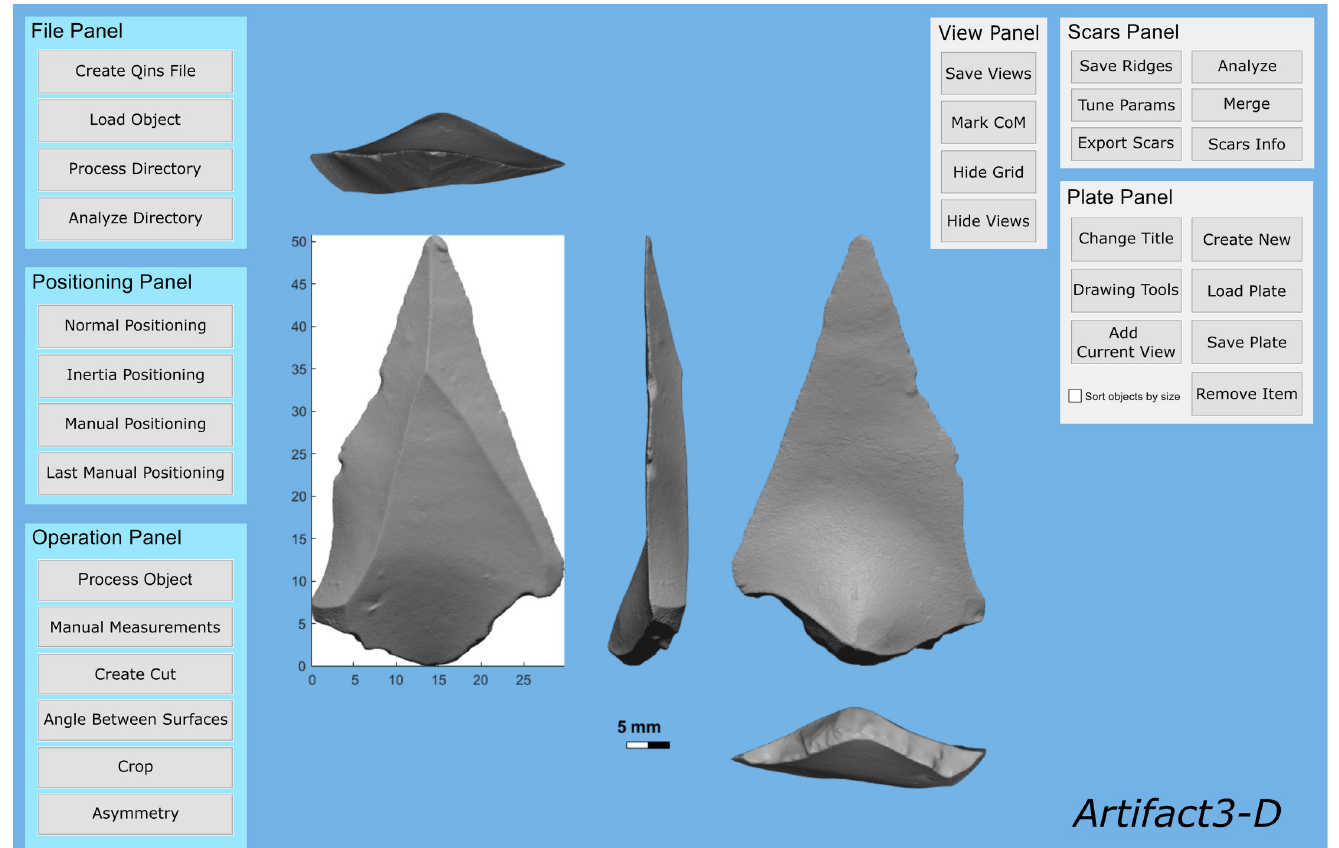
Fig 1. The primary interface of the Artifact3-D program, showing the main functions that can be conducted on an artifact.